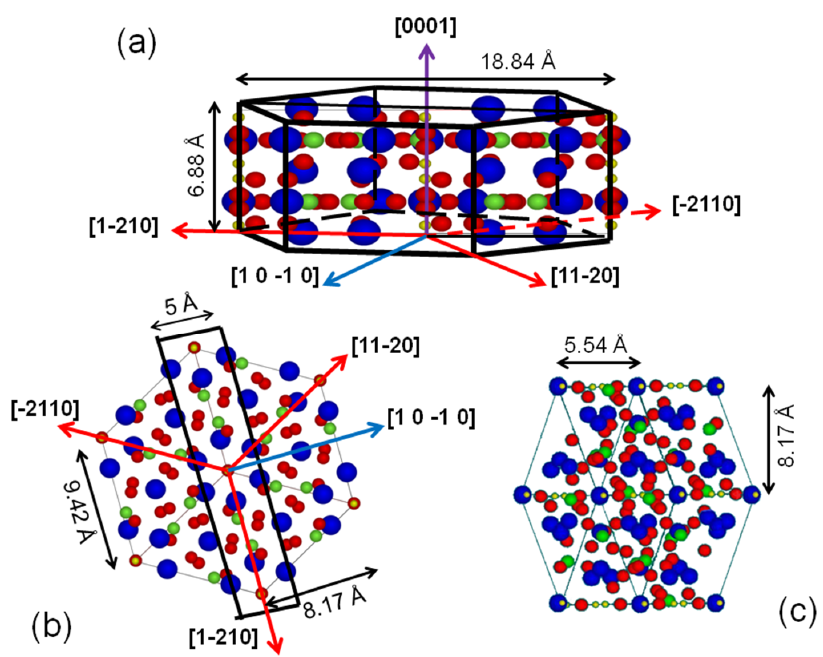
Figure 4. ( a ) Electron diffraction pattern of a human tooth enamel crystal along the [10-10] axis. It was indexed with the hexagonal hydroxyapatite (HAP) unit cell. ( b ) The [1000], [10-11], and [1-210] diffraction patterns, which are perpendicular to the [10-10] axis. The color of the line indicates the zone axis of the diffraction pattern of the squares with the same color.